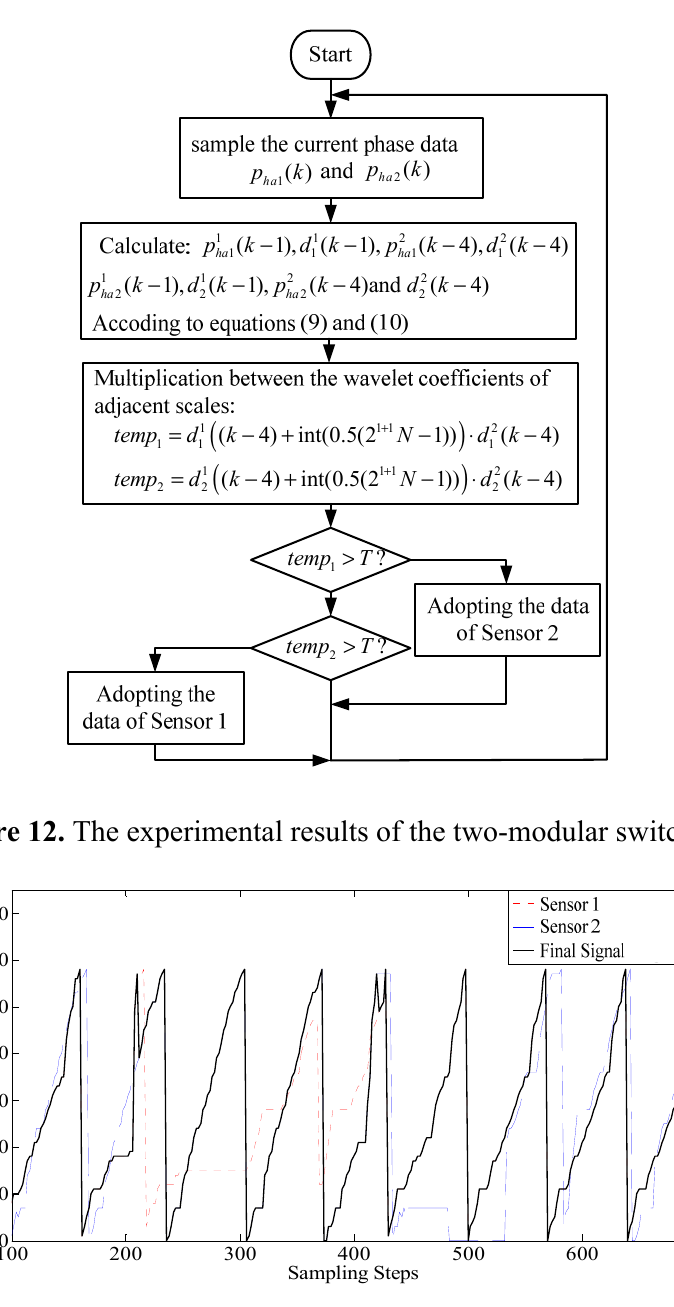
Figure 11. The flow chart of the switching algorithm.